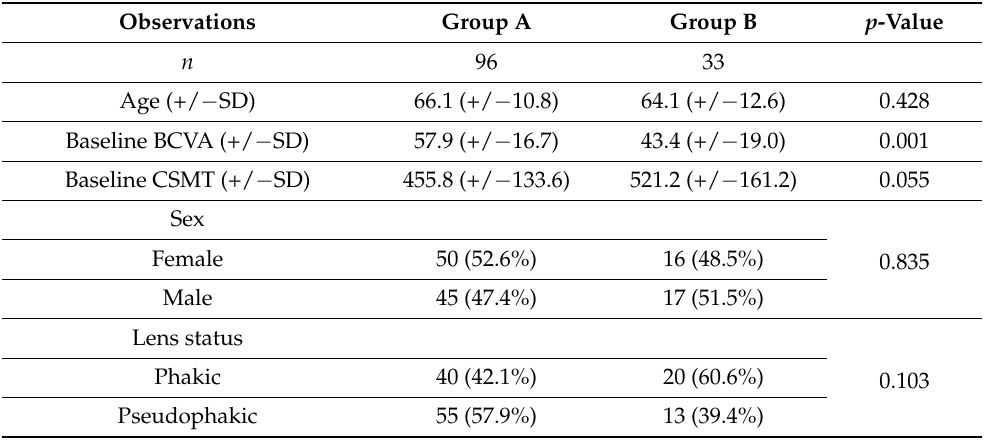
Table 2. Patient baseline characteristics between Group A and Group B for visual acuity (VA) gain profiles. (BCVA = best-corrected visual acuity; CSMT = central subfield macular thickness; HIP = high intraocular pressure; HBP = high blood pressure; PRP = panretinal photocoagulation; SRF =